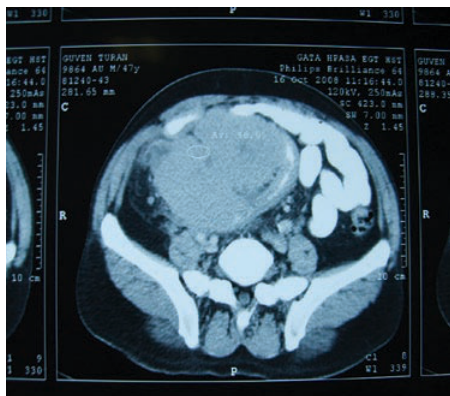
Figure 1. CT demonstrating a large abdominal mass in the right abdomen (arrow).